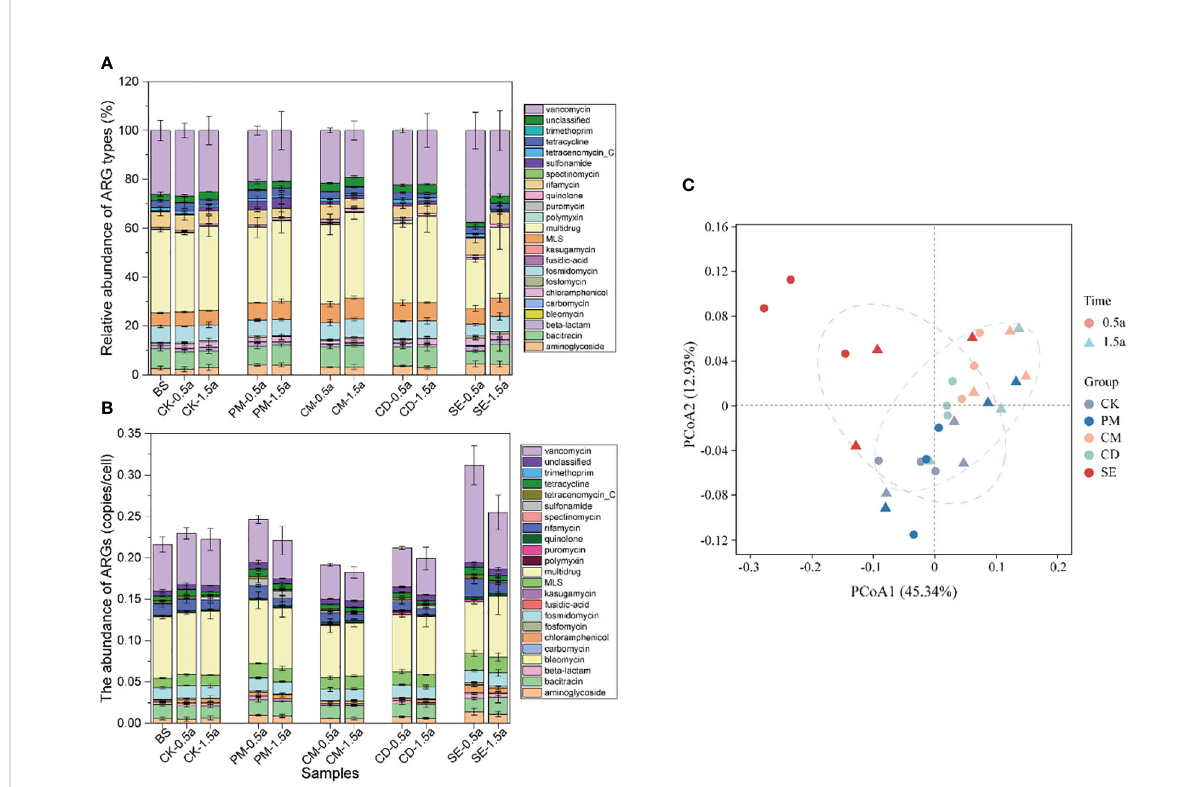
FIGURE 1 Pro fi le of antibiotic resistance genes (ARG) types from different manure-amended soils at 0.5 and 1.5 years. (A) Percentage of ARG types in different samples. (B) Relative abundance of ARG types in different samples. (C) Principal coordinate analysis showing the overall distribution pattern of ARG types among different samples. BS, background soil; CK, chemical fertilizer application soil; PM, pig manure application soil; CM, chicken manure application soil; CD, cow dung application soil; SE, silkworm excrement.